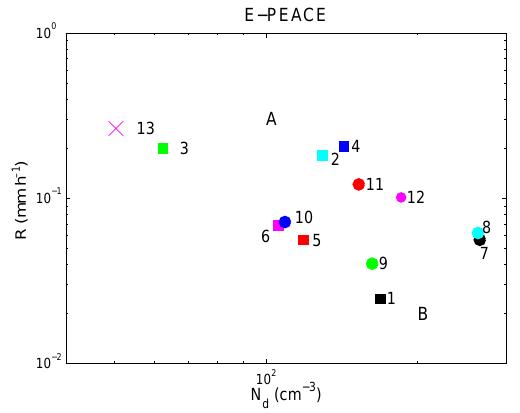
Figure 7. Daily mean values of N d and R for the 13 E-PEACE flights. Numbers indicate the flight numbers shown in Table